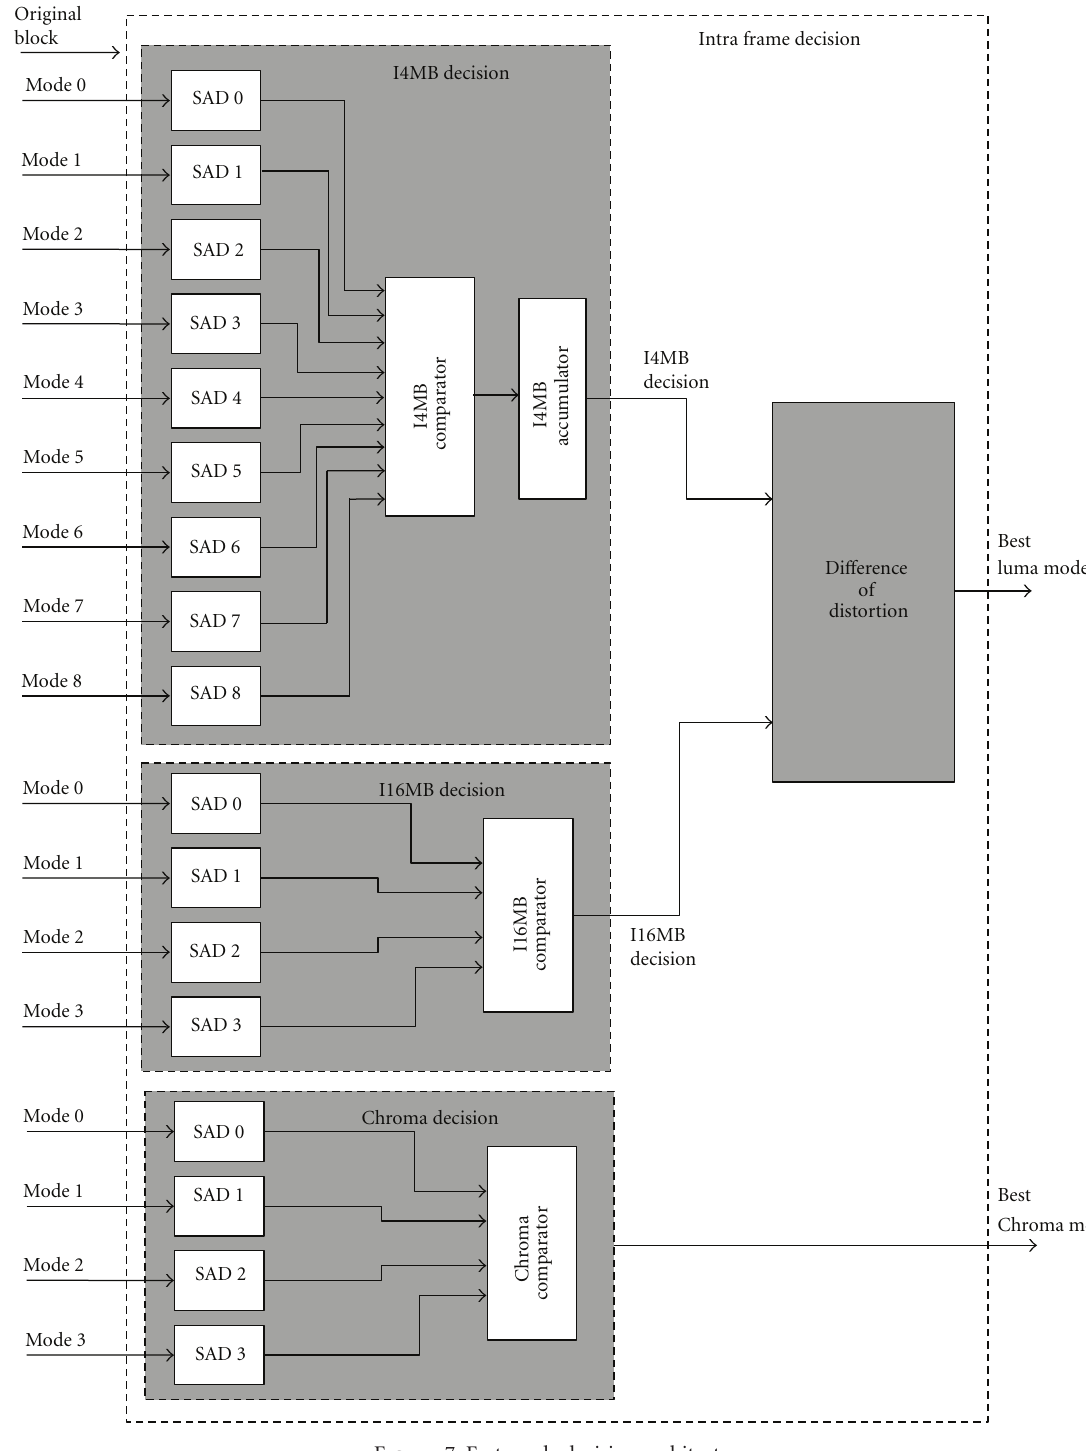
Figure 7: Fast mode decision